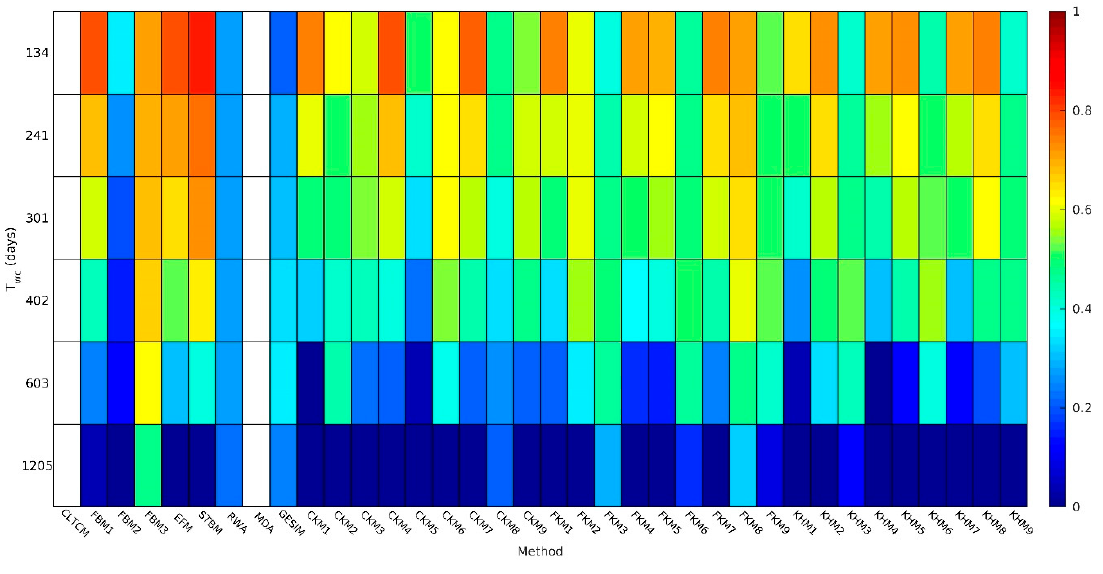
Figure 6. Average cumulative skill score of the five random sequences of the simulated methods.